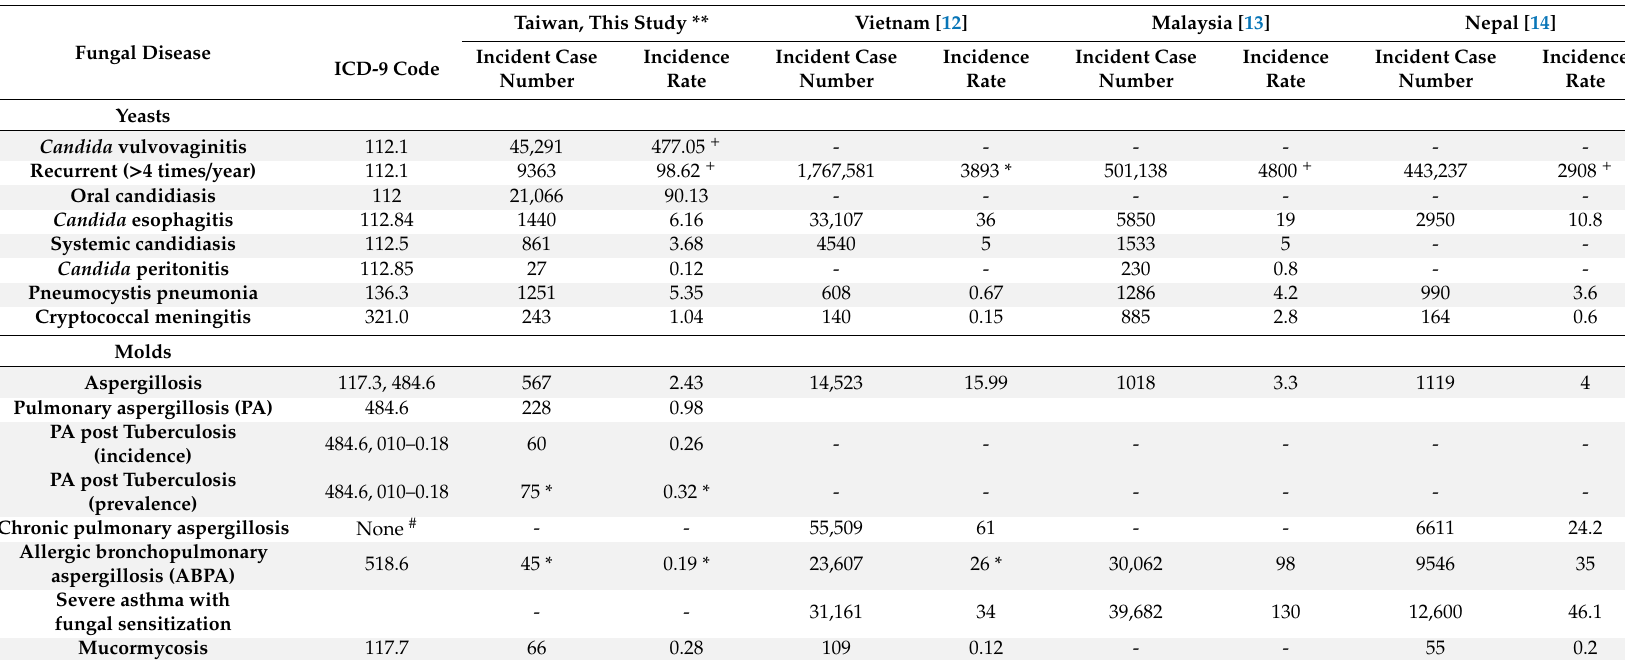
Table 1. The estimated annual incident case numbers and incidence rates of selected fungal diseases in 2013 in Taiwan and those in other Asian countries.